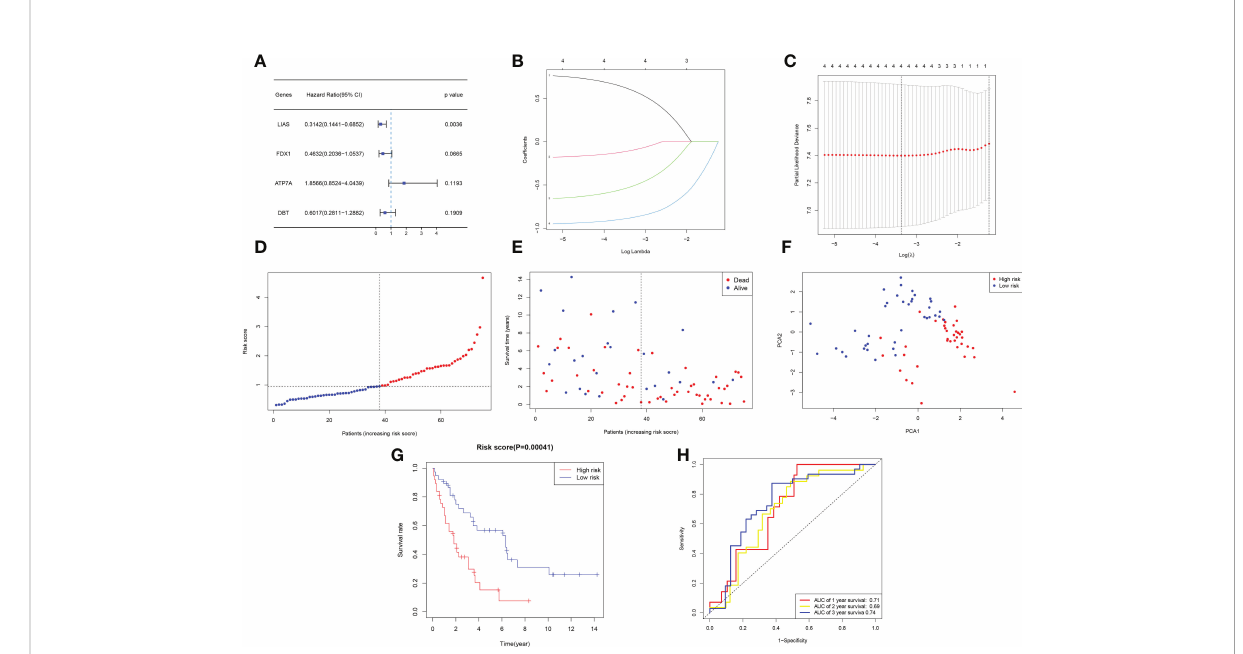
FIGURE 3 Development of a prognostic model based on the E-MTAB-6389 cohort. (A) Forest plot demonstrating prognosis-related genes by univariate Cox analysis. (B – C) A prognostic signature consisting of 4 genes was constructed through LASSO Cox regression. (D) Distribution of 109 patients based on the risk score (red: high risk, blue: low risk; the dotted line represents the median value). (E) The survival status of each patient (left side: low-risk group; right side: high-risk group). (F) PCA plot based on the risk score. (G) Kaplan − Meier survival curve according to the risk score of patients in the E-MTAB-6389 cohort. (H) ROC curves at 1, 3, and 5 years to evaluate the sensitivity and speci fi city of the risk